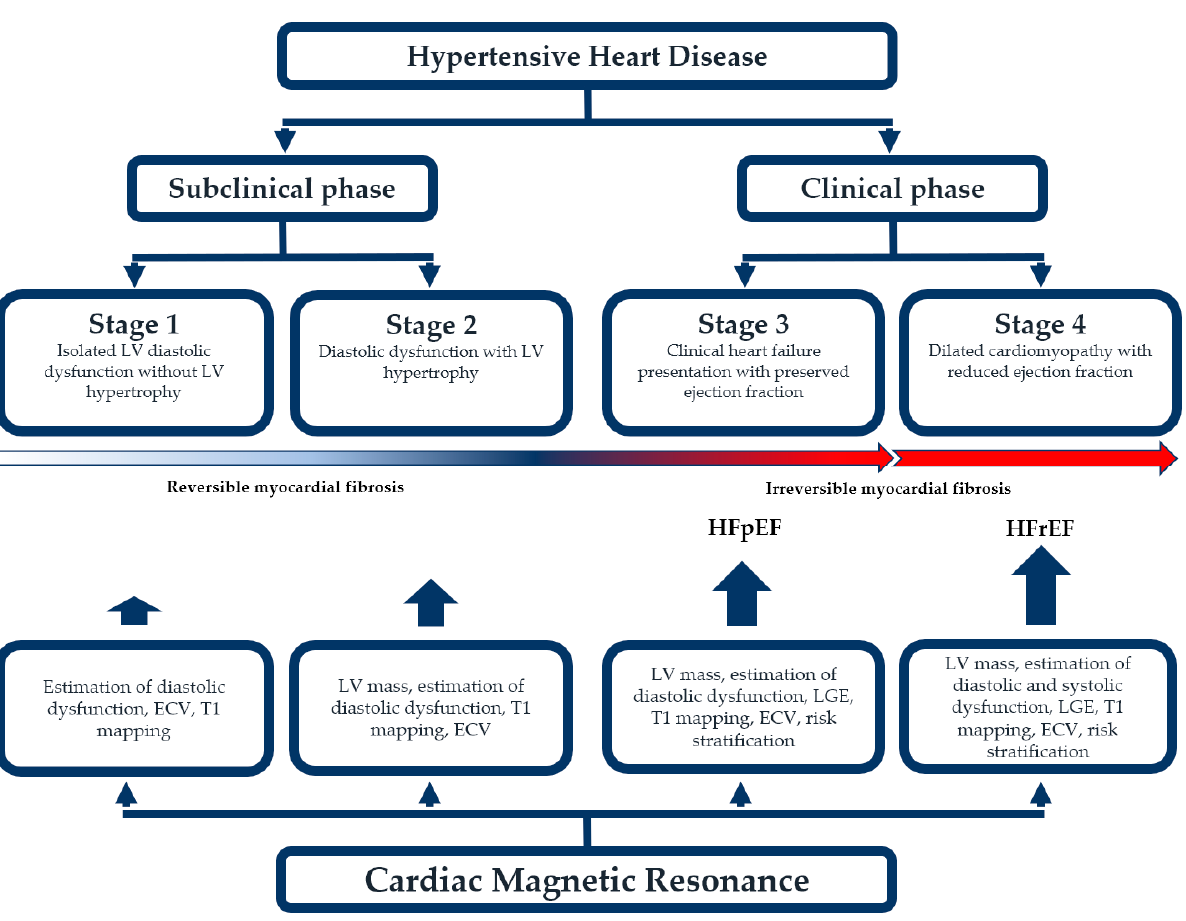
Figure 3. The utility of cardiac magnetic resonance in different stages of hypertensive hearts disease.